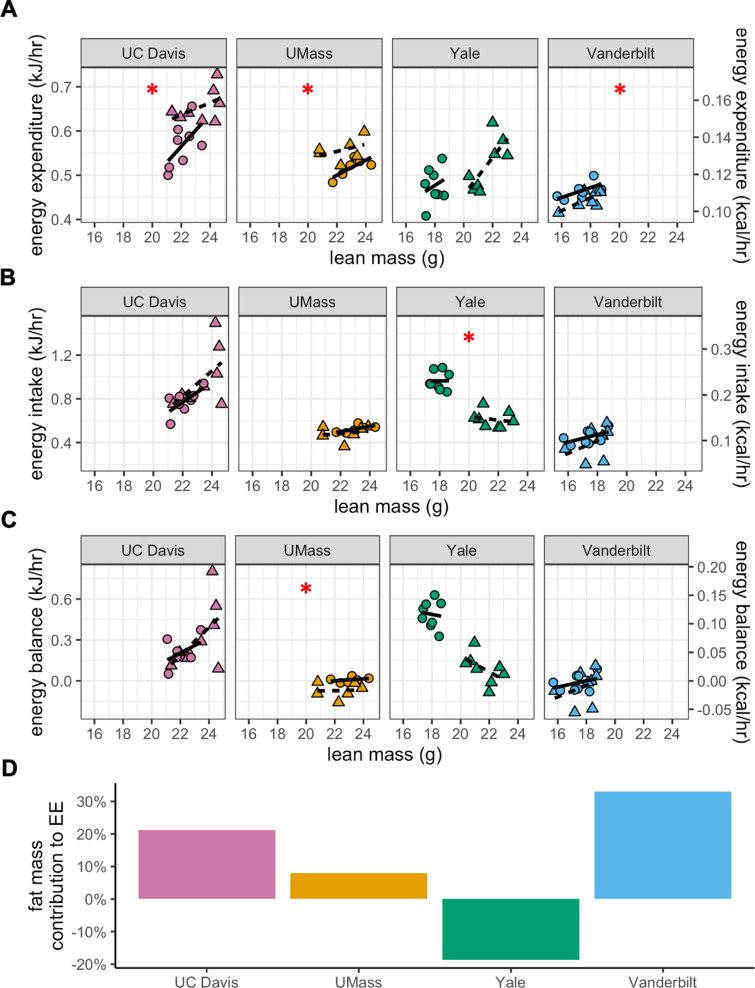
MMPC experiment: energy balance using lean mass as a covariate.Data as in Figure 3, using the lean mass as the covariate in place of total mass. Regression plots for each of the MMPC sites vs mass. EE (A). Energy intake (B). Energy balance (C). Relative contribution of fat mass to EE for each site from a linear regression model (D). n = 6–8 males per group.